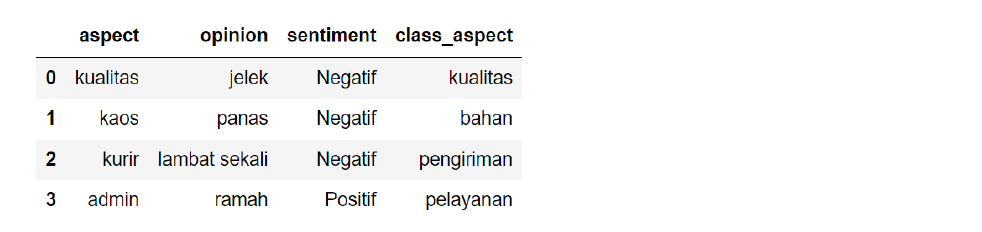
Figure 18. The example-2 of using ABSA model.